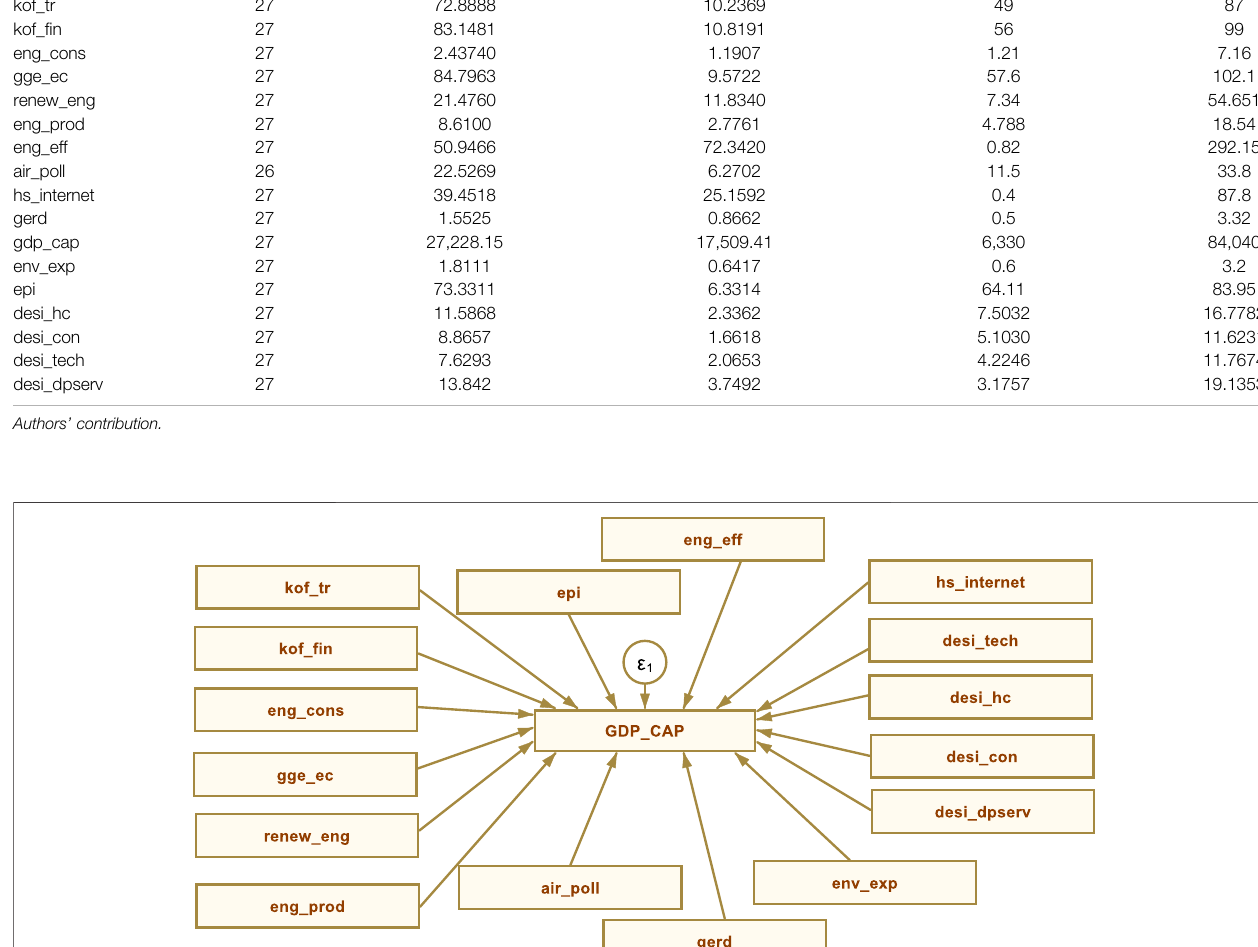
Frontiers in Environmental Science |